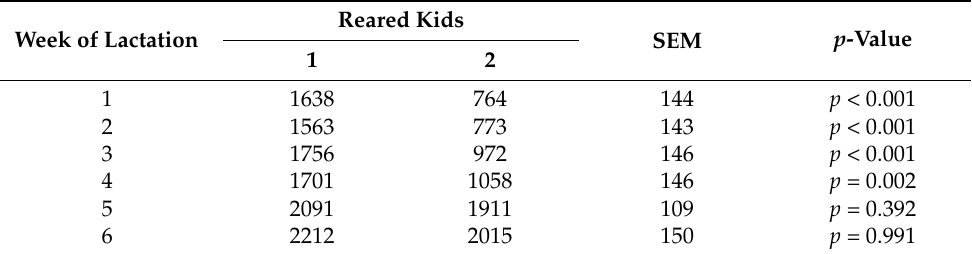
Table 4. Consumed milk mean values (ml) according to the number of kids reared (1,2) and the genetic type, in a mixed rearing system (MG = Murciano-Granadina; B = Boer). Reared Kids Genetic Type Week of SEM p -Value SEM p -Value Lactation 1 2 MG MG × B 1 962 2152 166 p < 0.001 1523 1591 118 p = 0.658 2 963 2358 168 p < 0.001 1621 1701 119 p = 0.899 927 1979 170 p < 0.001 1389 1527 121 p = 0.325 4 877 1891 173 p < 0.001 1316 1451 124 p = 0.284 654 1738 174 p < 0.001 1110 1282 125 p = 0.913 644 1554 151 p < 0.001 957 1170 130 p = 0.614 Fat and protein milk composition ( p < 0.001), the energy of the milk ( p = 0.001) and the SCClog ( p = 0.027) changed significantly based on the stage of lactation and, for SCClog, also on the interaction between number of kids reared*lactation week ( p = 0.037). Average values of the potential milk energy (Table 5) fluctuated between 3574 and 3772 kj/kg for the first two weeks of lactation, while they did not exceed 3441 kj/kg in the rest of the weeks of the experimental period, similar to what happens with milk fat and protein, with those that presented positive and significant correlations (r = 0.96 p < 0.001 and r = 0.78 p < 0.001, respectively). In turn, the logarithm of the SCC presented mean values of 5.6 ± 0.01. Table 5. Average values (kj/kg) of the potential milk energy according to the number of kids reared (1,2), in a mixed rearing system. Reared Kids SEM Week of Lactation 3710 p = 0.966 3772 p =